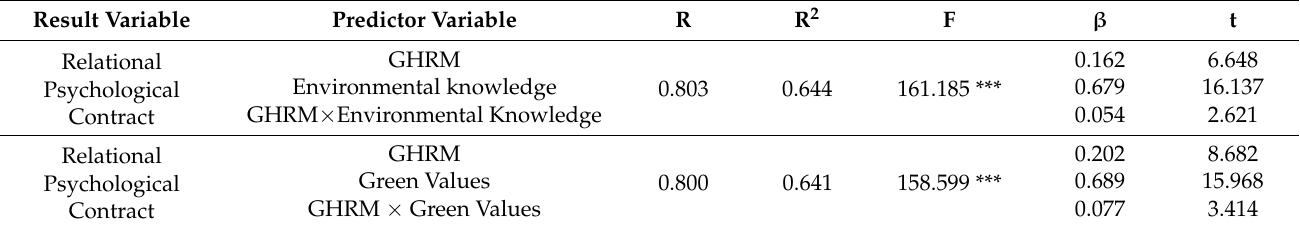
Table 5. Mediation model test with adjustment.